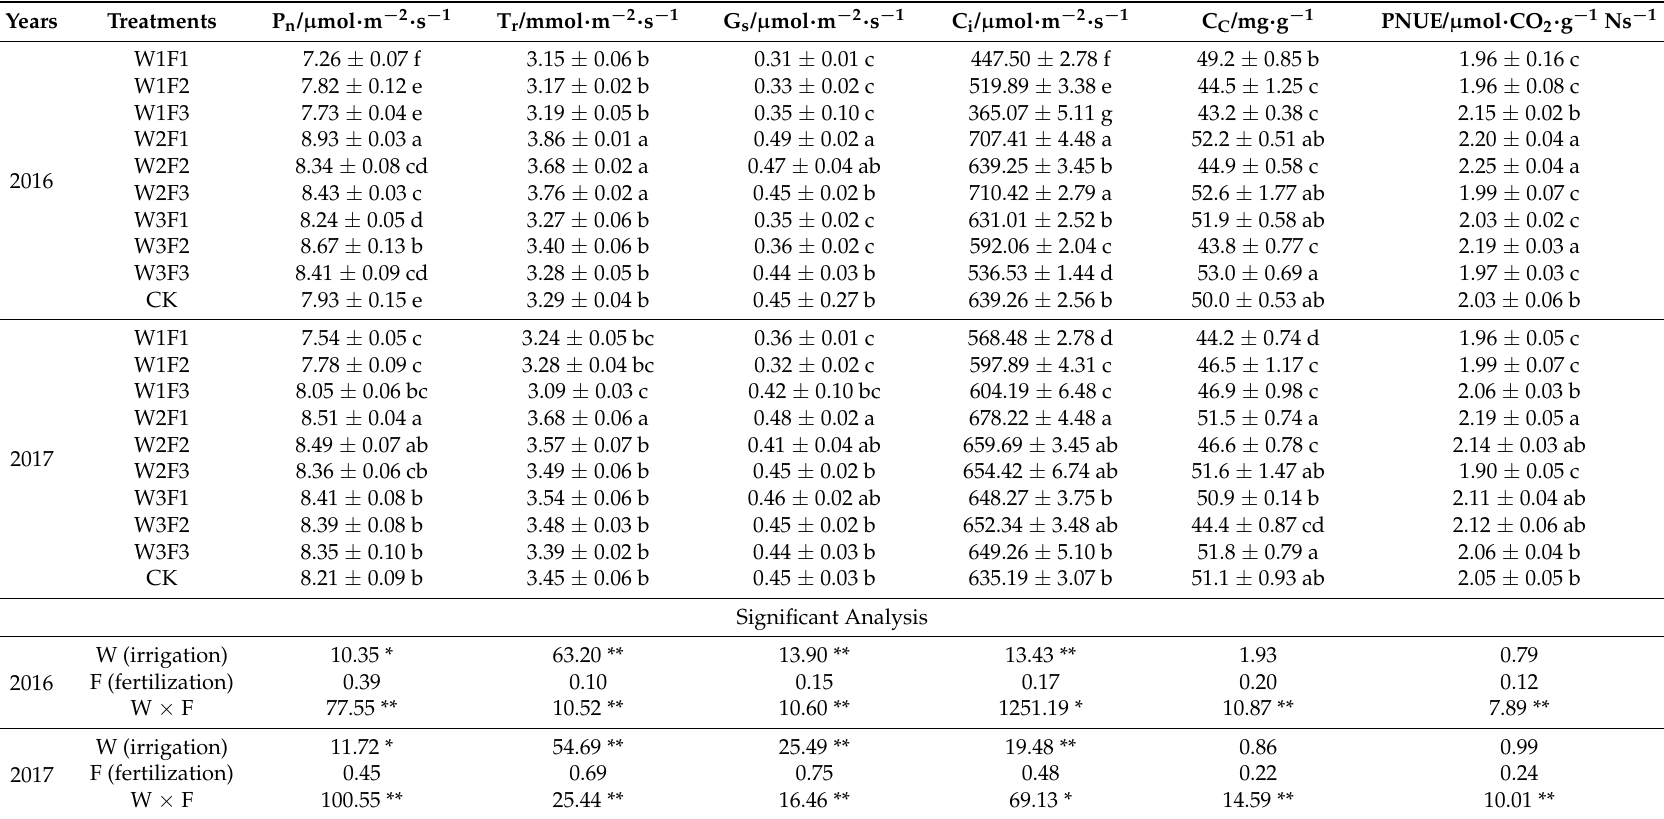
Table 3. Effects of water–fertilizer treatments on photosynthetic